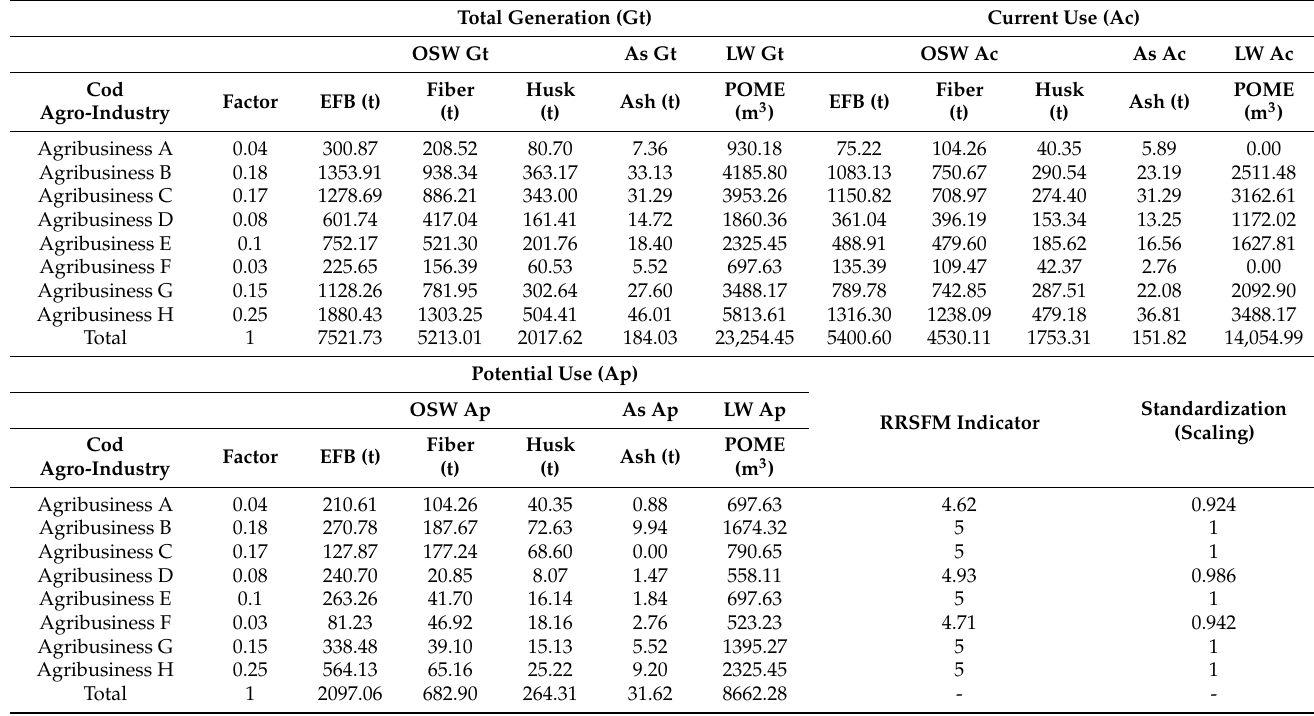
Table 9. Total generation (Gt), current use (Ac), potential use (Ap) of palm oil residues and by- products in the Casanare Department by agribusiness or processing